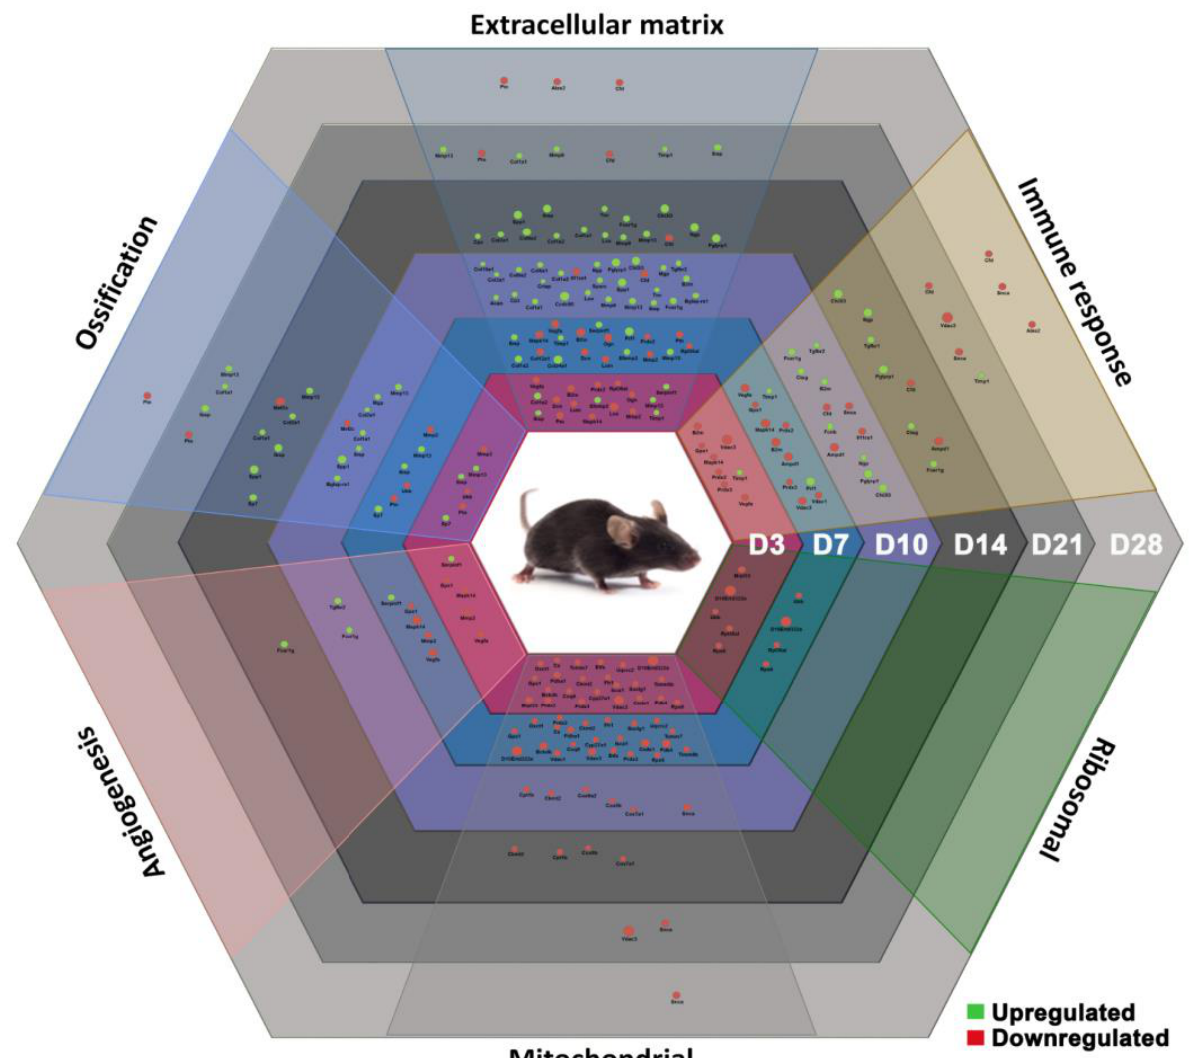
Figure 8. Hexagon summarizes the temporal distribution of differentially expressed genes involved in immune response, angiogenesis, ossification, ECM regulation, mitochondrial, and ribosomal ac- tivity.